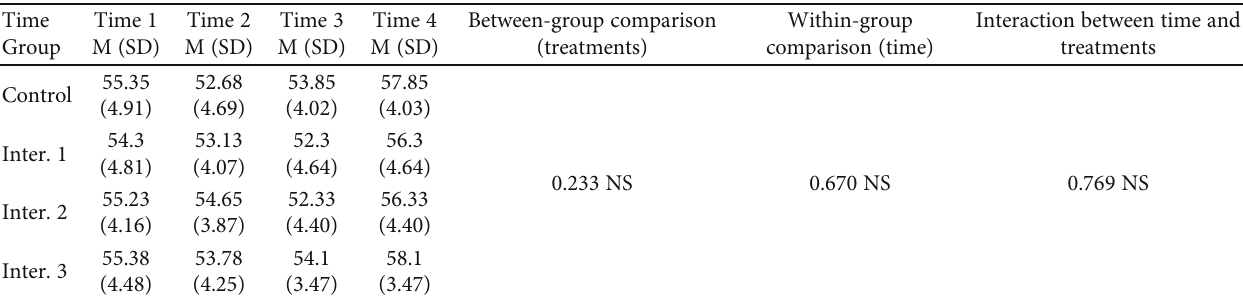
Table 4: Comparisons between trial and control groups in terms of trait anxiety at baseline (time 1), 6 months (time 2), 15 months (time 3), and 21 months (time 4) after the intervention.